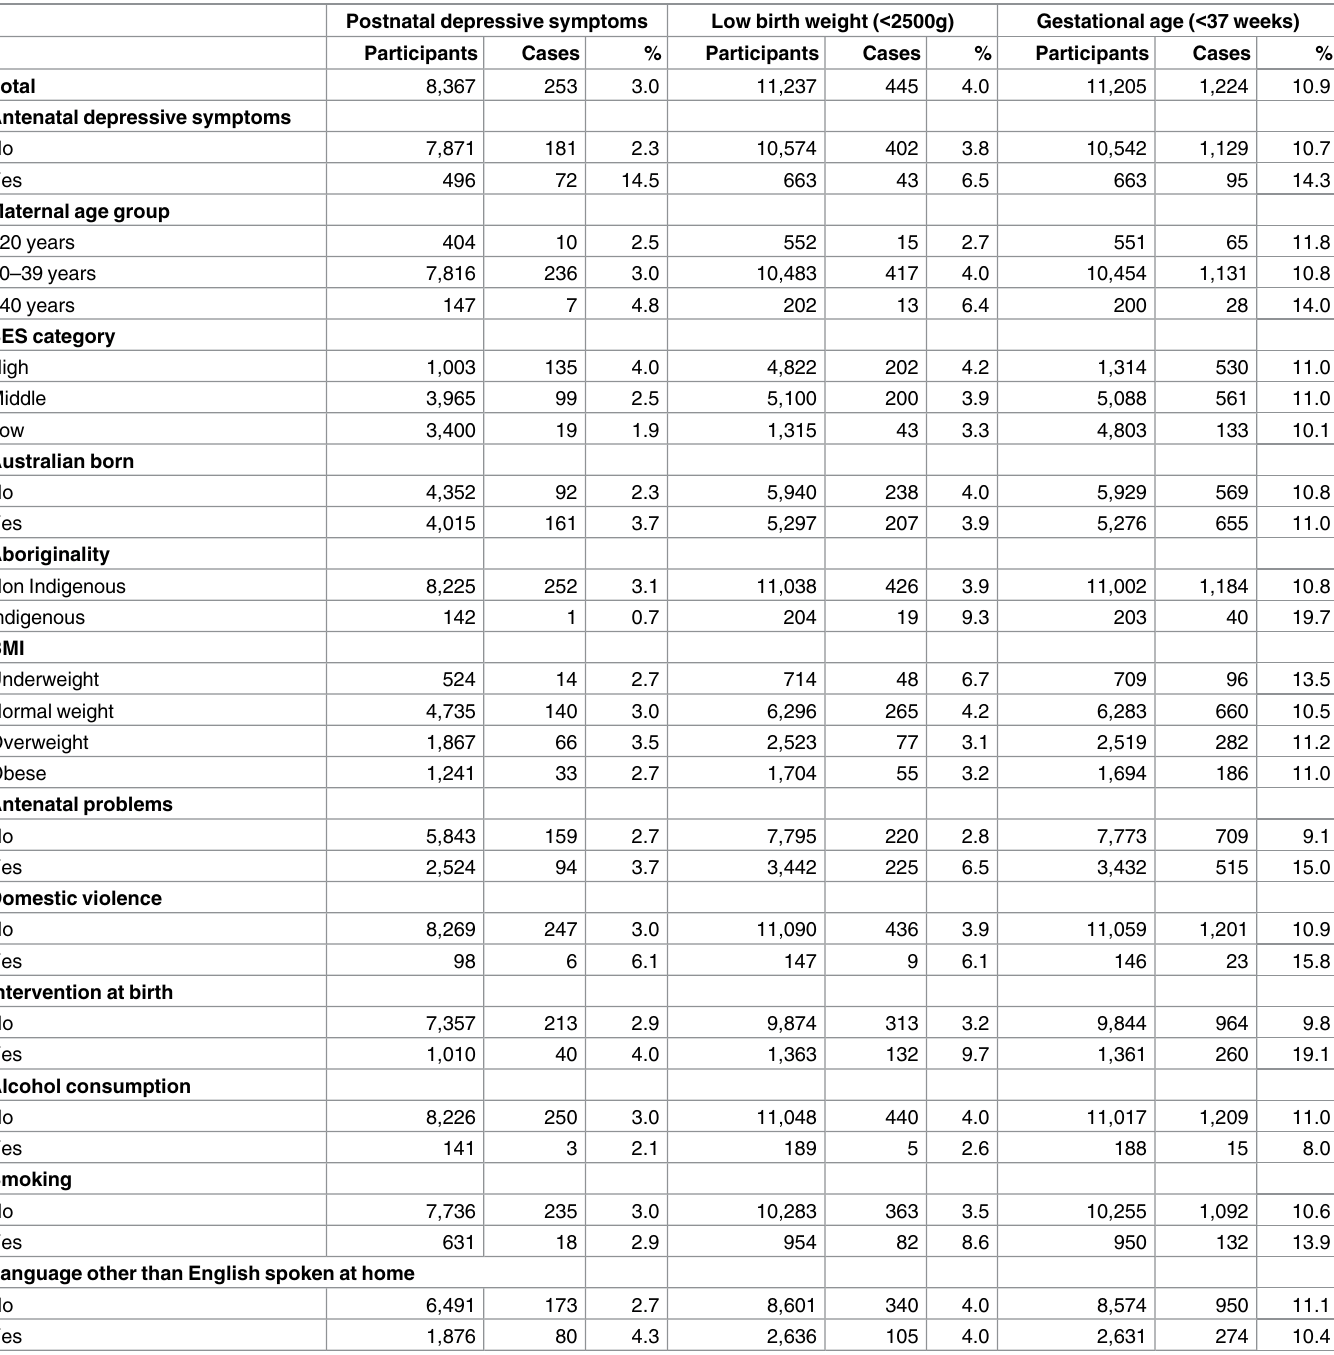
Table 1. Prevalence of postnatal depressivesymptoms and perinatal outcomes by study